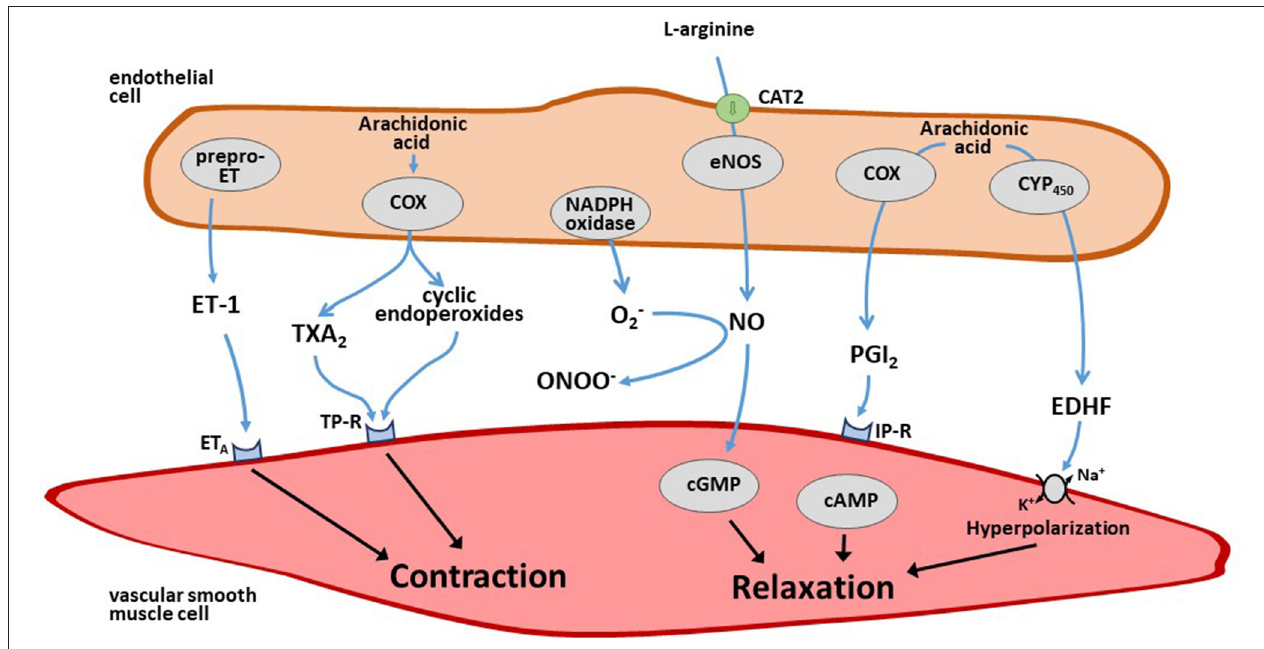
FIGURE 3 | Schematic overview of endothelium-derived vasoconstrictor and vasodilator mediators. The endothelium produces several vasoconstrictor mediators like endothelin-1 (ET-1) and thromboxane (TX) A 2 as well as vasodilator mediators like nitric oxide (NO), prostacyclin (PGI 2 ), and endothelium-derived hyperpolarizing factor (EDHF) that diffuse to the adjacent smooth muscle cells that effect changes in vascular tone upon this stimulation. For further details see